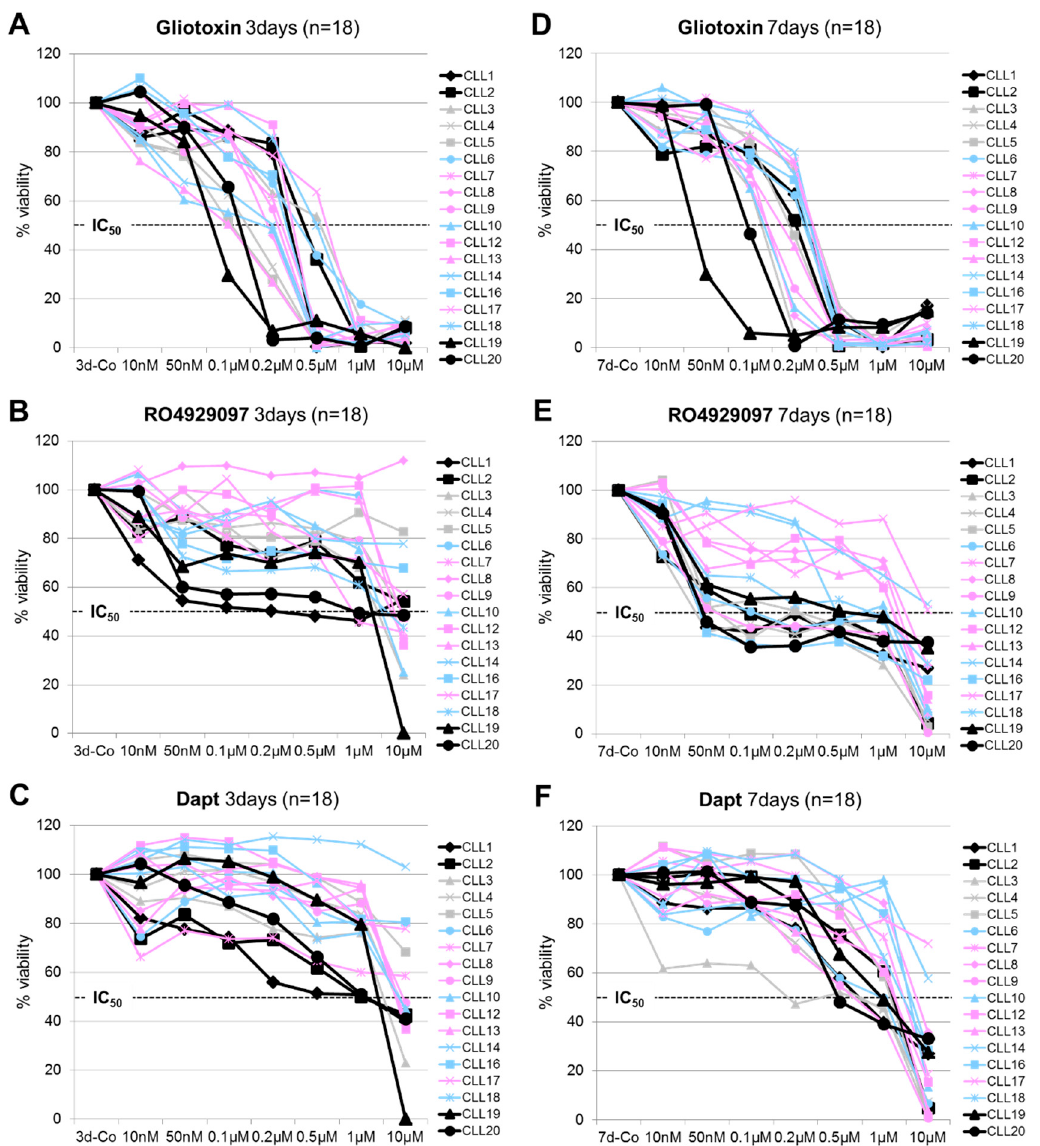
Figure 1. The dose- and time-dependent effect of gliotoxin, RO4929097, and DAPT on CLL cell viability in vitro. Eighteen CLL cases, including 4 cases with the recurrent NOTCH1 ∆ CT mutation (black lines), 6 cases expressing GSI-R nuclear NOTCH2 (pink lines), and 5 cases expressing GSI-S nuclear NOTCH2 (blue lines), were subjected to MTT assays and the relative inhibition of cell viability in response to the indicated drug concentrations was determined after 3 ( A – C ) and 7 days ( D – F ), respectively. The percent inhibition relative to the controls was calculated from the mean OD (optical density) values from CLL samples cultured in triplicates. The IC 50 of the individual compounds is indicated.